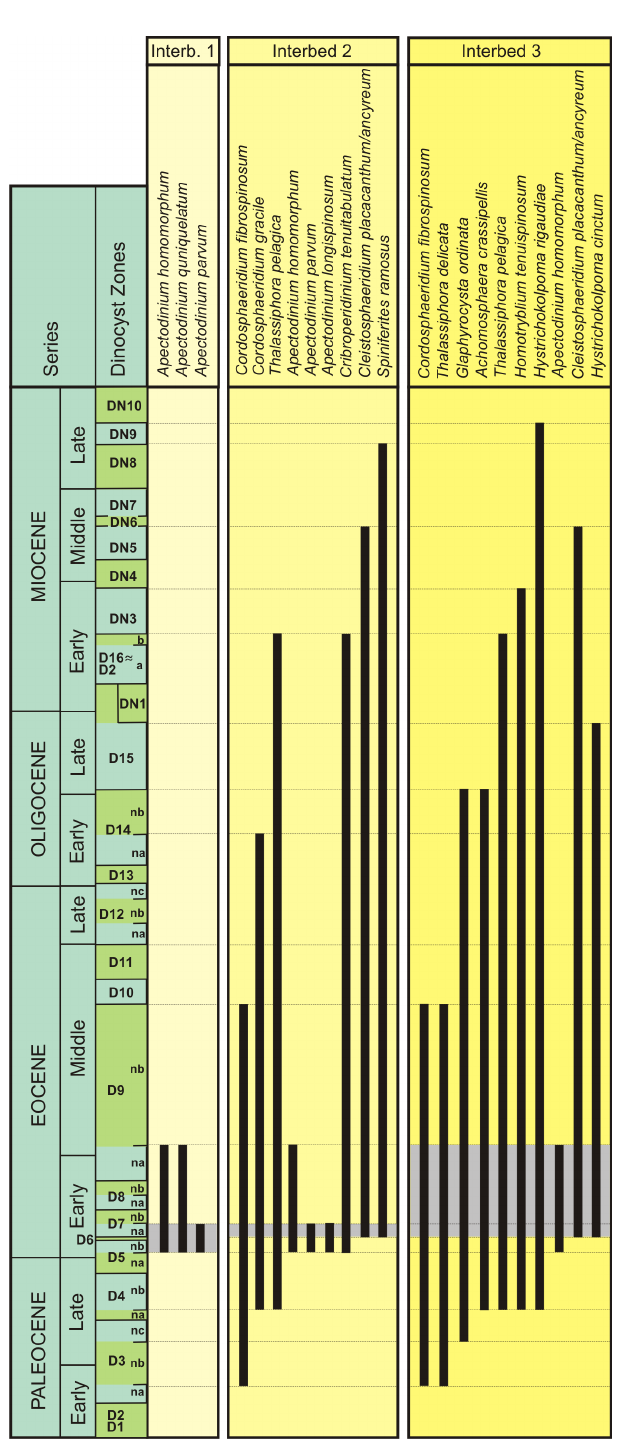
Figure 2. Stratigraphic range of dinoflagellates identified in In- terbed 1, Interbed 2, and at the base of Interbed 3 using the dinoflag- ellate zones of Köthe (2003) and Köthe and Piesker